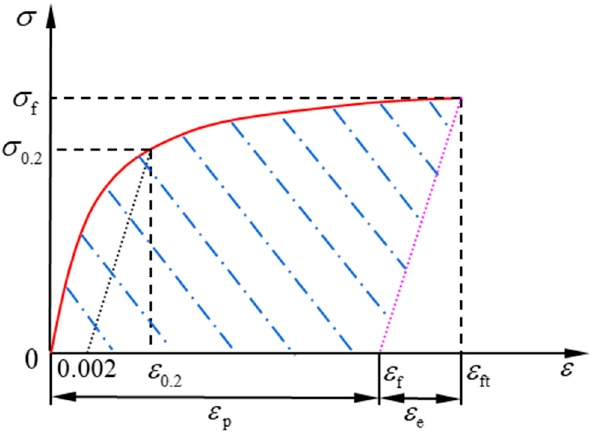
Figure 1. Non-linear stress–strain curve.